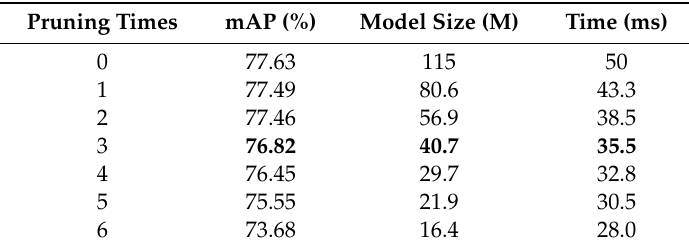
Table 4. The mAP, model size and elapsed time with 6 prunings.